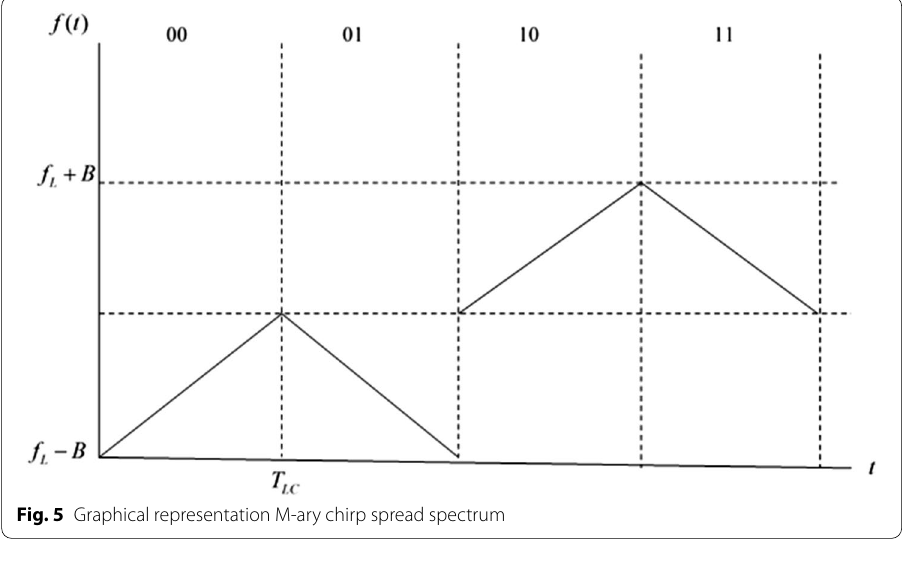
Fig. 5 Graphical representation M-ary chirp spread spectrum